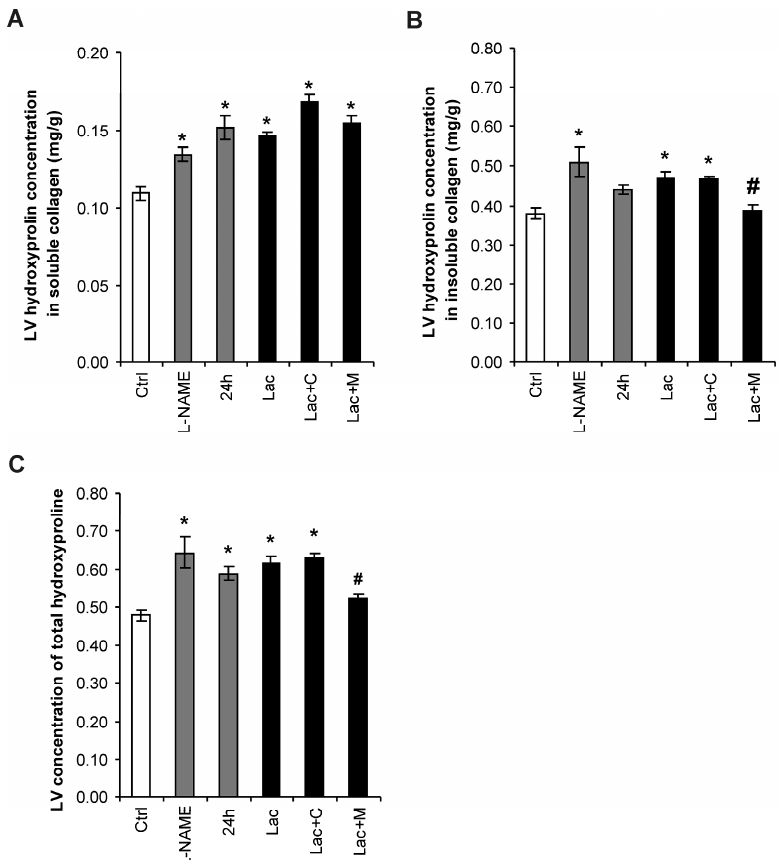
Figure 3. Hydroxyproline concentration in the LV in soluble ( A ) and insoluble ( B ) collagen, and total hydroxyproline ( C ) in the control group (Ctrl), L-NAME (L-NAME)-, continuous 24 h/day light (24 h)-, lactacystin (Lac)-induced hypertension, and in lactacystin-hypertension influenced by captopril (Lac+C) or melatonin (Lac+M). * p < 0.05 vs. Ctrl, # p < 0.05 vs. Lac.